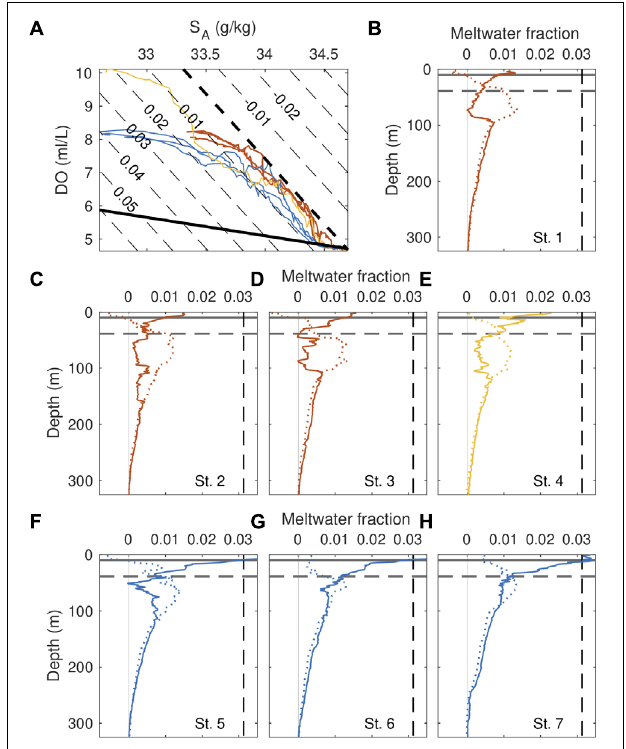
FIGURE 6 | Water column glacial meltwater content and distribution. (A) Dissolved oxygen – salinity profiles. Dashed black line links properties of deep mUCDW and WW, and the solid black line links mUCDW and meltwater endmember properties. Gray contours correspond to isolines of meltwater fraction, computed following the Jen99 model. (B–H) Profiles of meltwater fraction for individual stations, with solid lines corresponding to estimates from Jen99 and dashed lines from Mor11. Dashed, black horizontal line corresponds to euphotic zone depth, while the solid black horizontal line indicates mixed layer depth. Dashed vertical line indicates the theoretical upper bound on meltwater fraction [ Supplementary Equation (10)